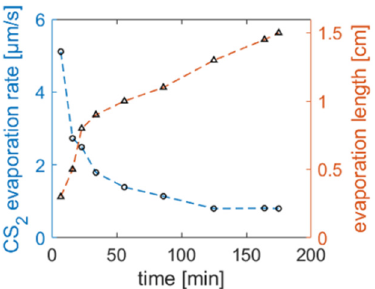
Figure A1. Measured evaporation rate of CS 2 in PCF (blue line) and the length of fiber in which CS 2 has been evaporated (red line).